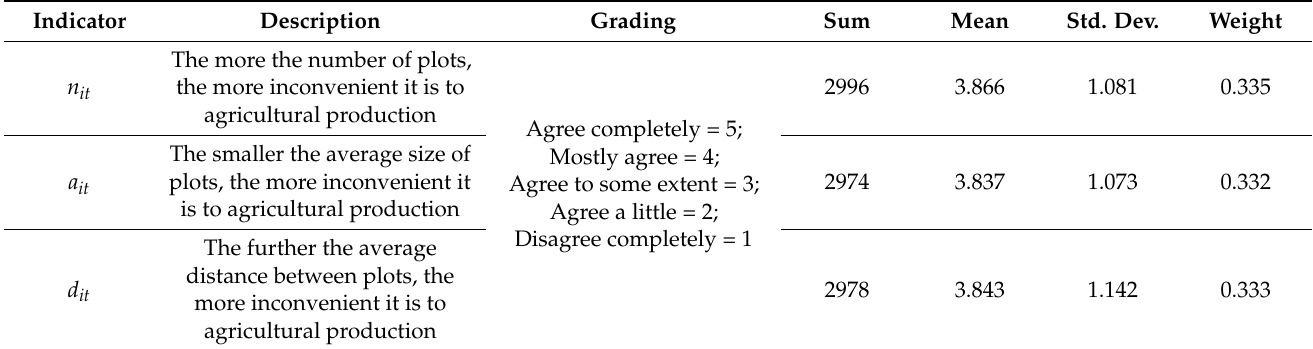
Table 1. Weights coefficient of measurement indicators of